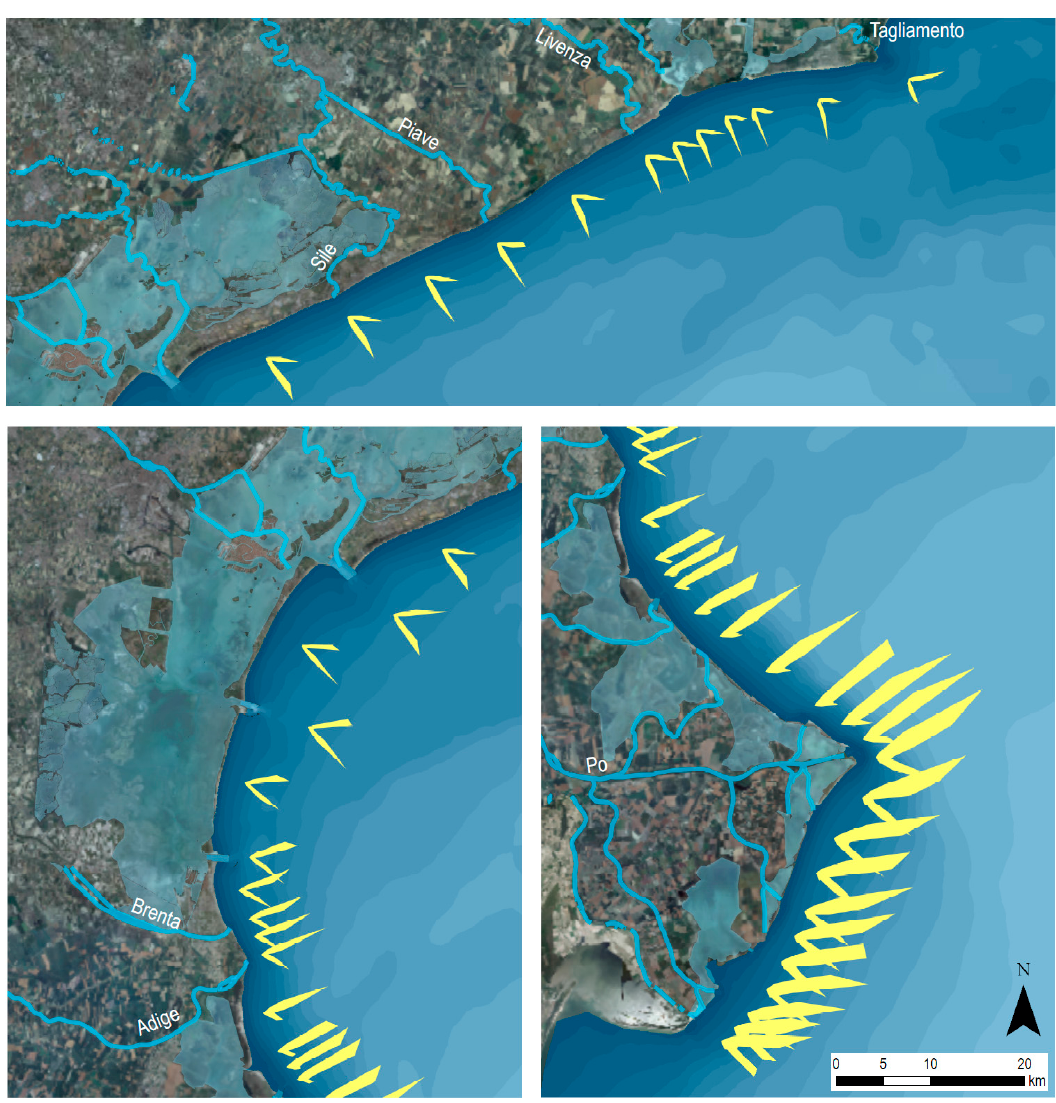
Figure 8. Nearshore wave climate (energy polar plot) for the Venetian littoral. The scale of the energy plot is common to the three images, allowing a qualitative comparison.